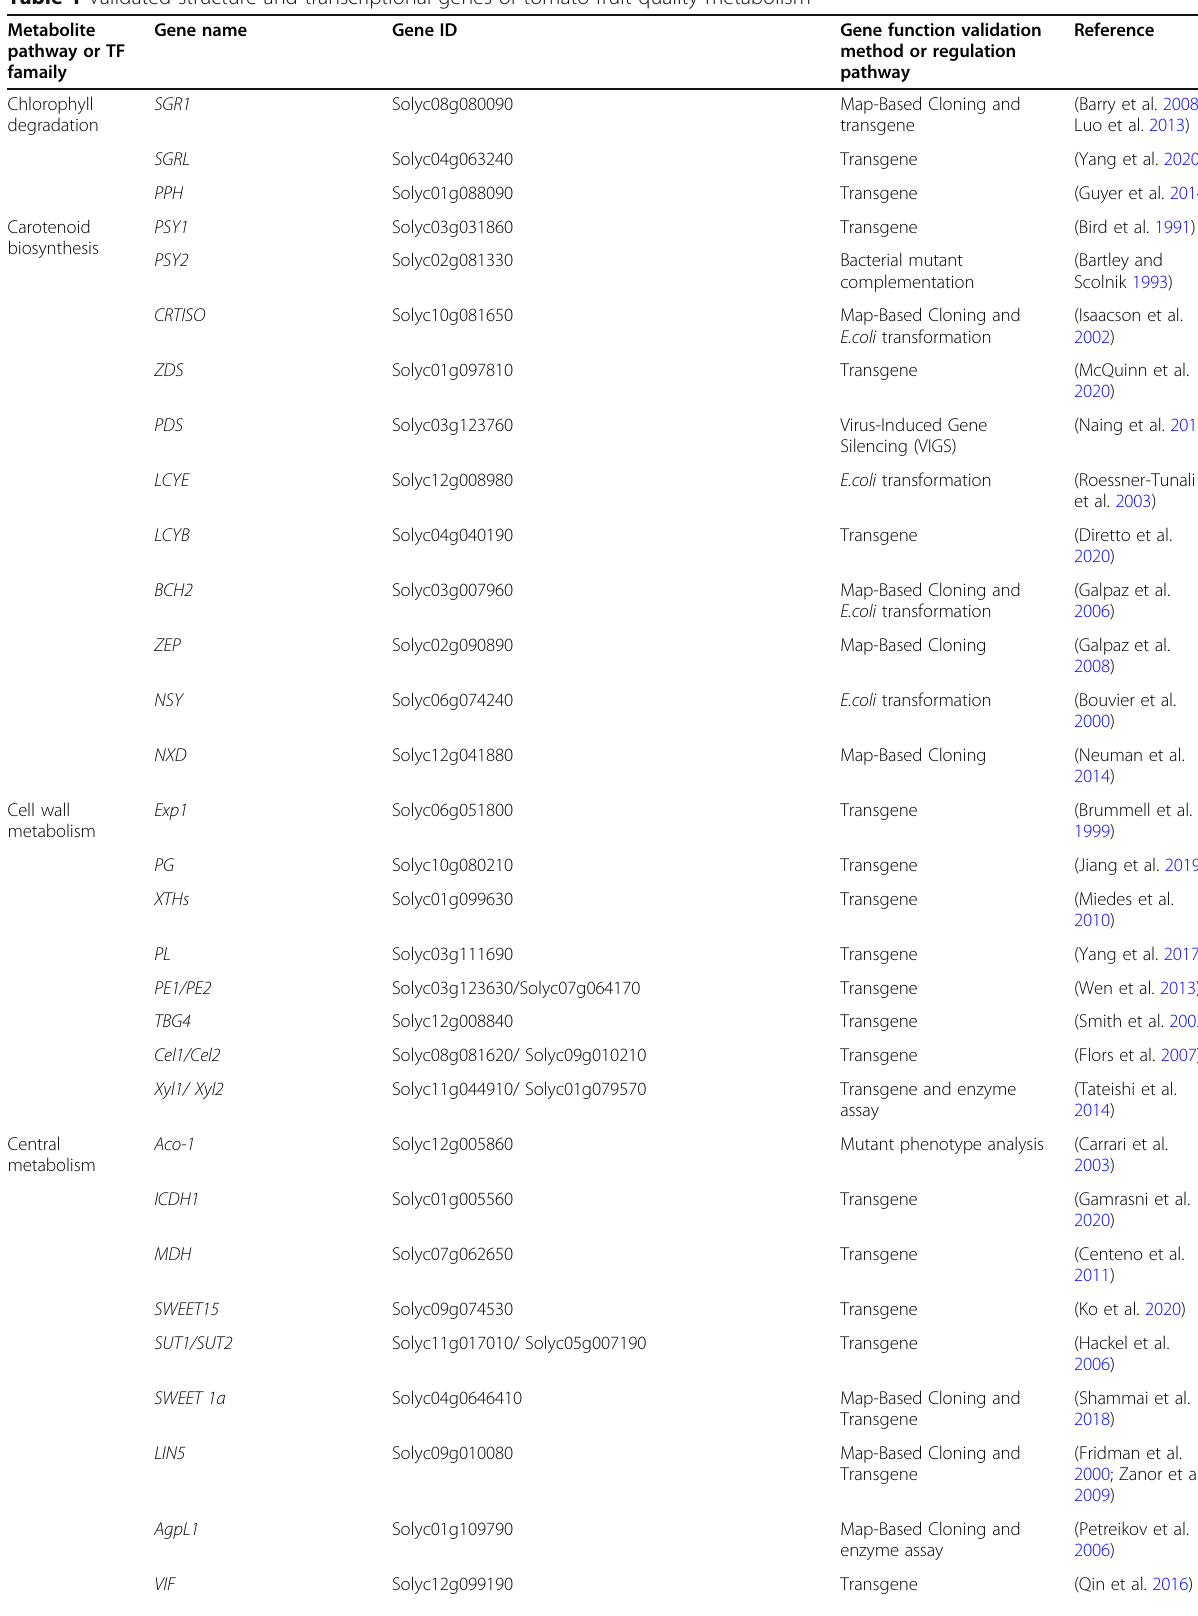
Table 1 Validated structure and transcriptional genes of tomato fruit quality metabolism Metabolite pathway or